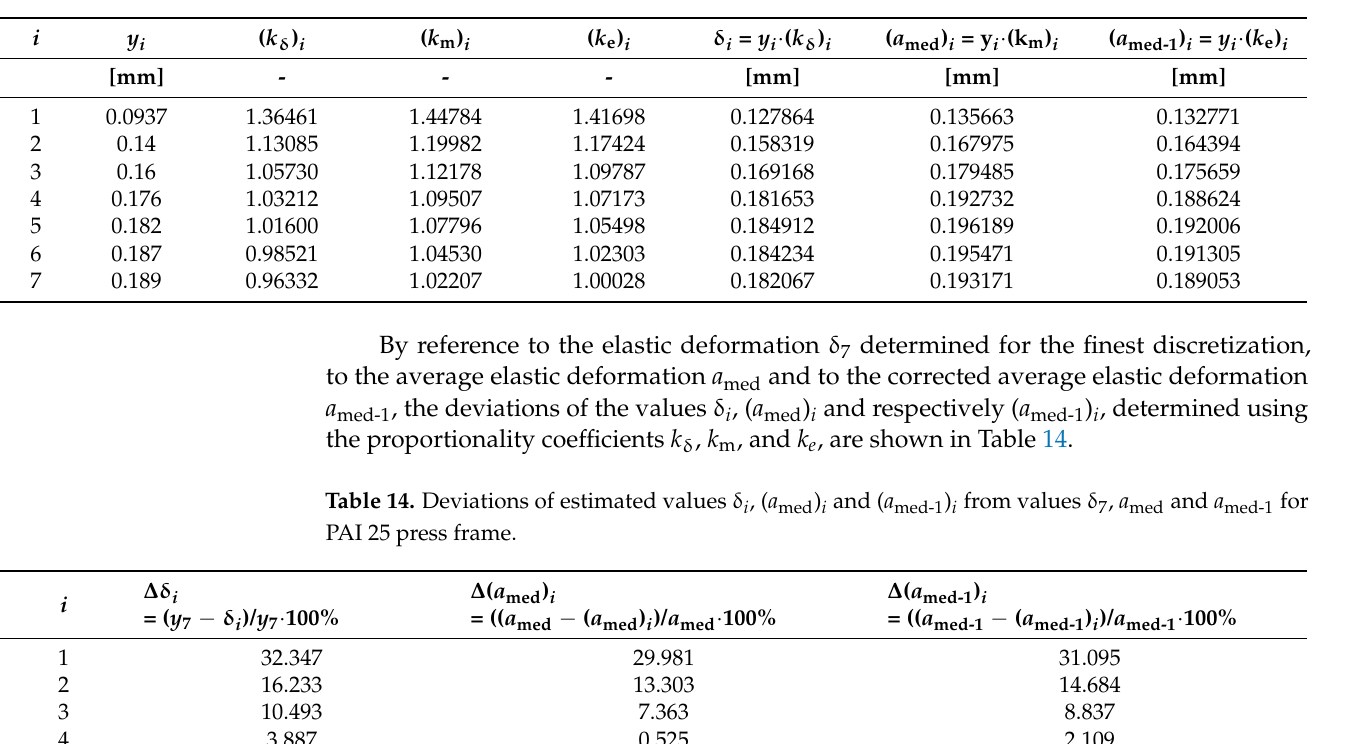
Table 13. Estimated values δ i , ( a med ) i and ( a med-1 ) i , for PAI 25 press frame determined through